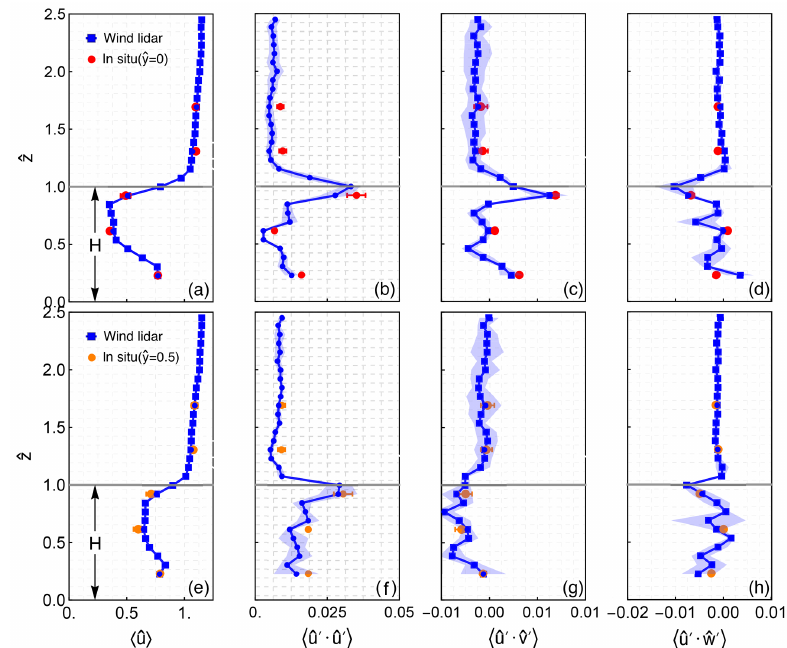
Figure 3. The vertical profile of the normalized mean streamwise wind speed (cid:104)ˆ u (cid:105) (a, e) , the longitudinal variance (cid:104)ˆ u (cid:48) ˆ u (cid:48) (cid:105) (b, f) , and the horizontal (cid:104)ˆ u (cid:48) ˆ v (cid:48) (cid:105) (c, g) and vertical (cid:104)ˆ u (cid:48) ˆ w (cid:48) (cid:105) (d, h) momentum fluxes, measured by the short-range WindScanner (blue) and downwind sonic anemometers in the centre of the wake at ˆ y = 0 (a–d) and at ˆ y = 0 . 5 (e–h) . The blue area corresponds to the estimated values of the statistical uncertainty in each quantity (see more in the “Methods” section). The dashed horizontal line in (b) and (d)–(f) corresponds to the tree